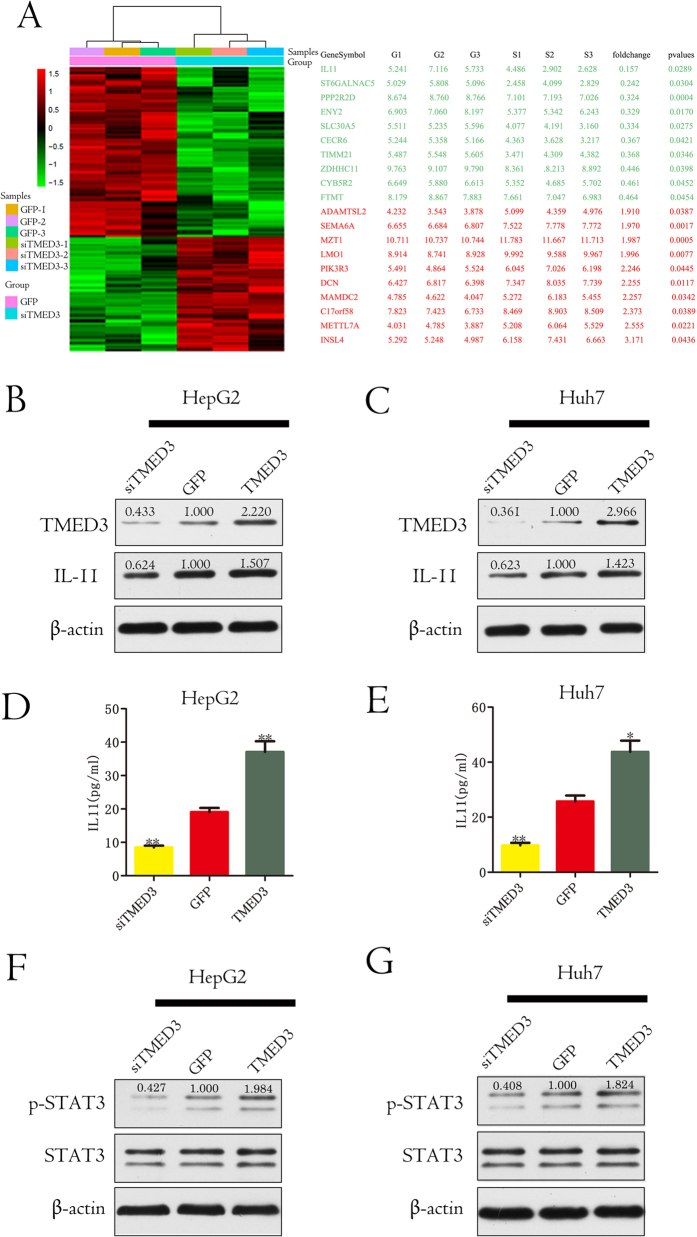
TMED3 promotes cell migration by increasing IL-11 expression.(A) Differentially expressed genes in HepG2-siTMED3 cells compared with control cells. The top 10 up- and down-regulated genes are listed on the right. (B,C) Relative IL-11 expression in cells with stable TMED3 knockdown or overexpression and paired controls. IL-11 expression was analyzed by western blot and normalized to β-actin. (D,E) The IL-11 concentration in culture medium from cells with stable TMED3 knockdown or overexpression and paired controls was determined by ELISA. n = 3, mean ± SD, the Student’s t test, *p < 0.05 versus GFP control, **p < 0.01 versus GFP control. (F,G) Relative P-STAT3 and STAT3 expression levels in cells with stable TMED3 knockdown or overexpression and paired controls were analyzed by western blot and normalized to β-actin. (B–G) n = 3.